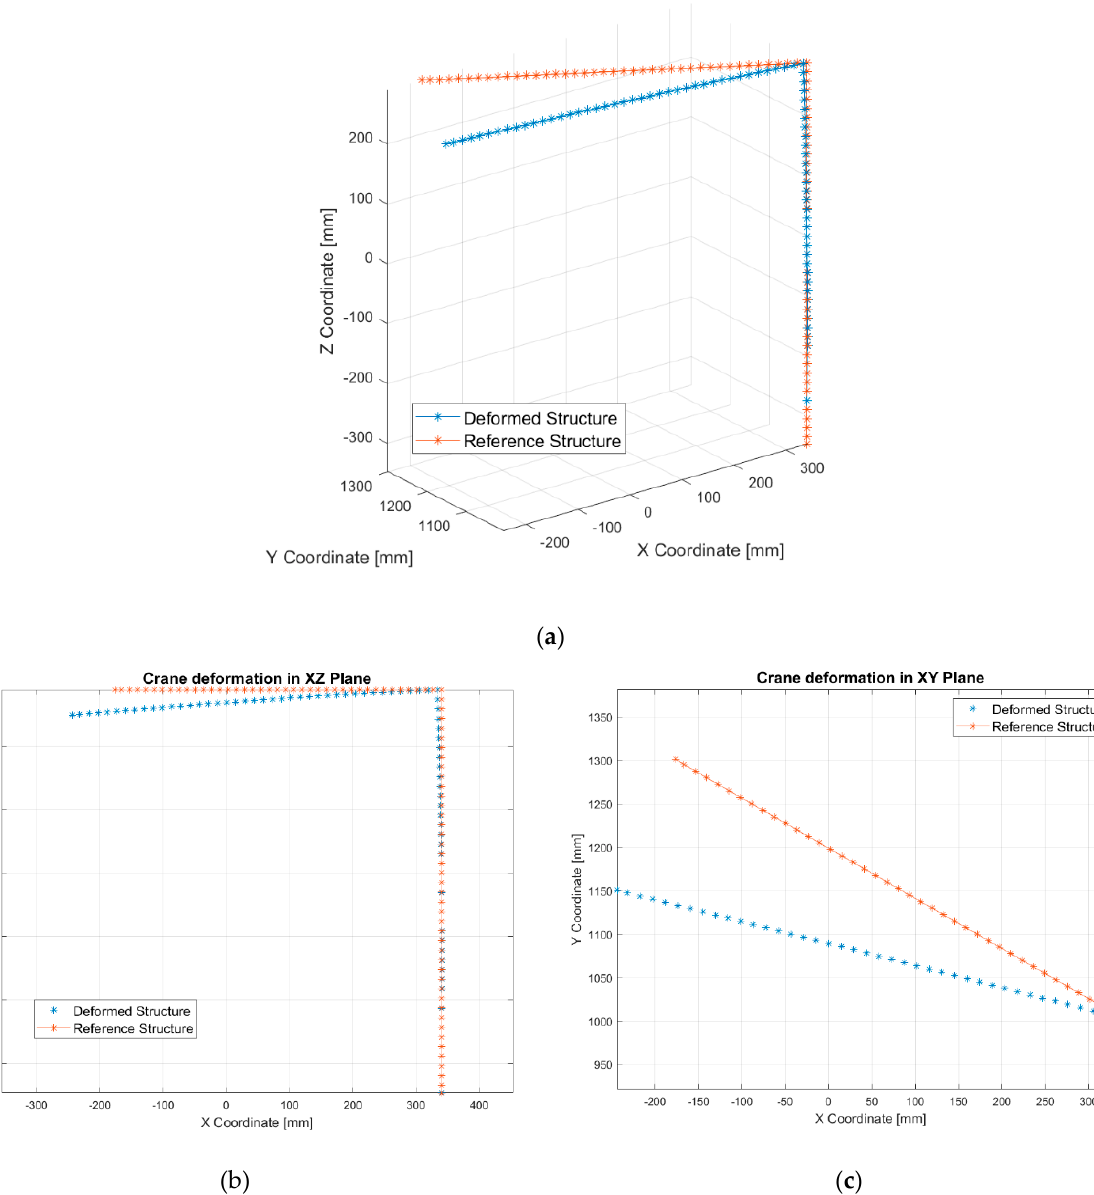
Figure 10. Three-dimensional (3D) reconstruction of the crane structure obtained using image data from the two-camera system: reference case (red) and after application of the load (blue). ( a ) Three-dimensional (3D) reconstruction and two projections; ( b ) projection on the XZ plane; ( c ) projection on the XY plane.